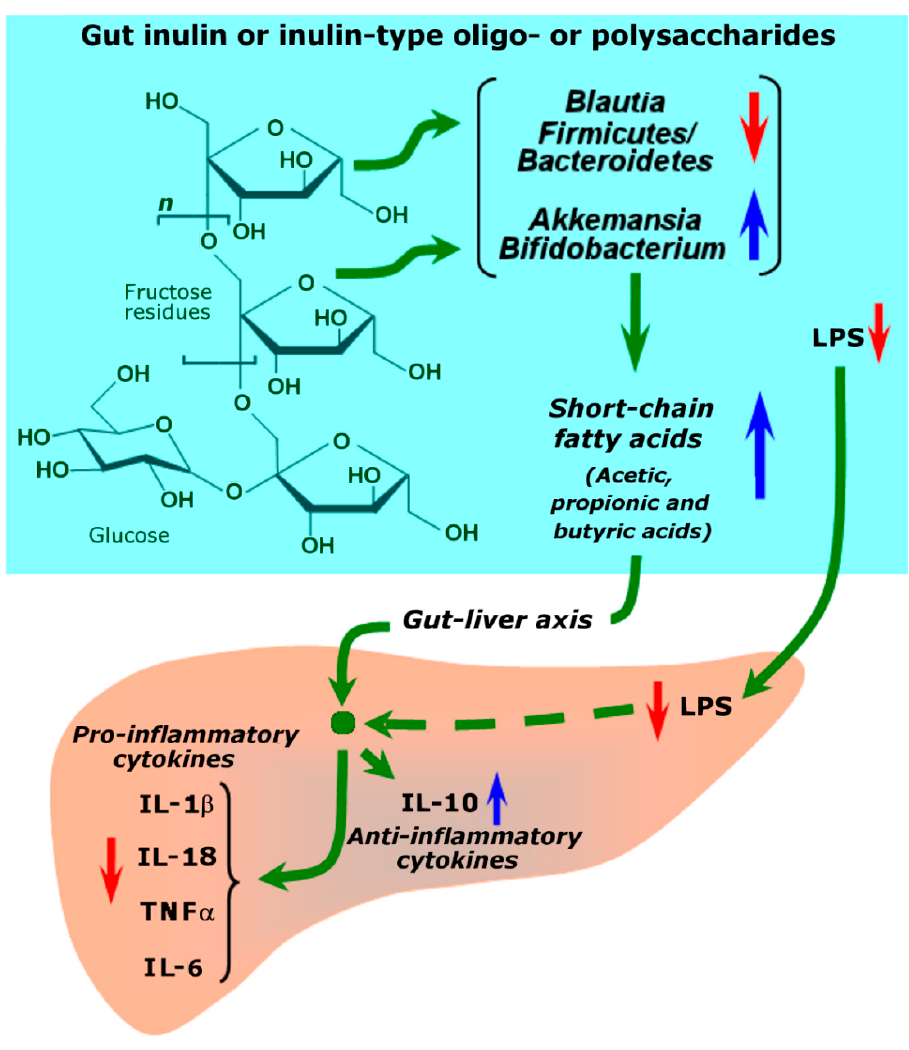
Figure 4. Possible mechanism of hepatoprotection by inulin polysaccharide or inulin oligosaccharides through the gut-liver axis. LPS refers to the gut microbial lipo-polysaccharide.